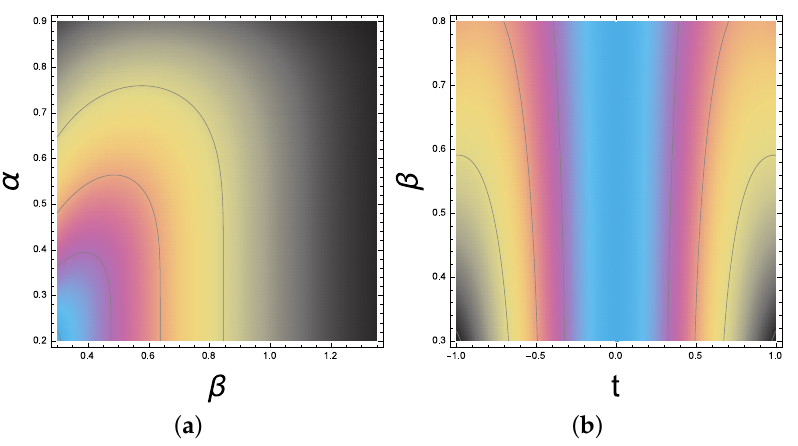
Figure 2. The pulse dynamics: the double exponential waveform for various shape factors. The pulse dynamics: ( a ) the double exponential waveform for various shape factors. β is a variable while α = 1.5. ( b ) The pulse shape has a symmetric behavior for t varying between − 1 and 1 which is interpreted by the colors around the blue centered line.